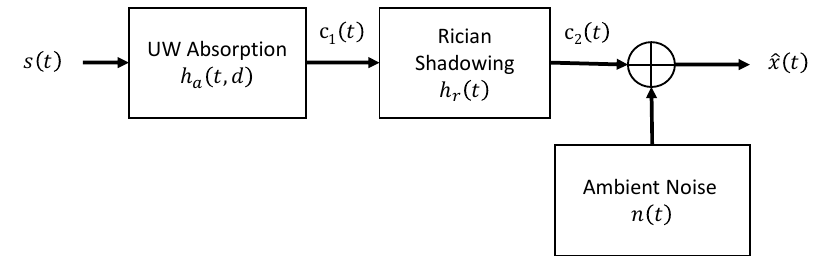
Figure 2 features the modulated time domain signal s ( t ) from Equation (3) passing